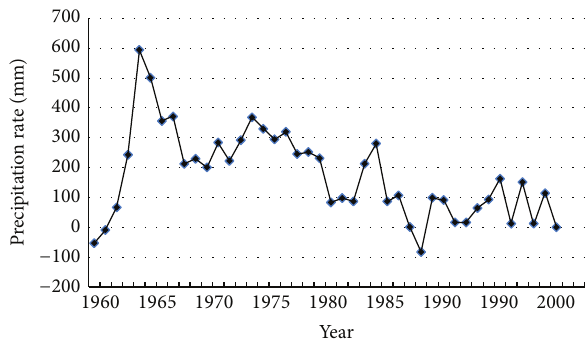
Figure 8: Cumulative average annual precipitation rate anomalies in the Lower Yellow River Region from 1960 to 2001.